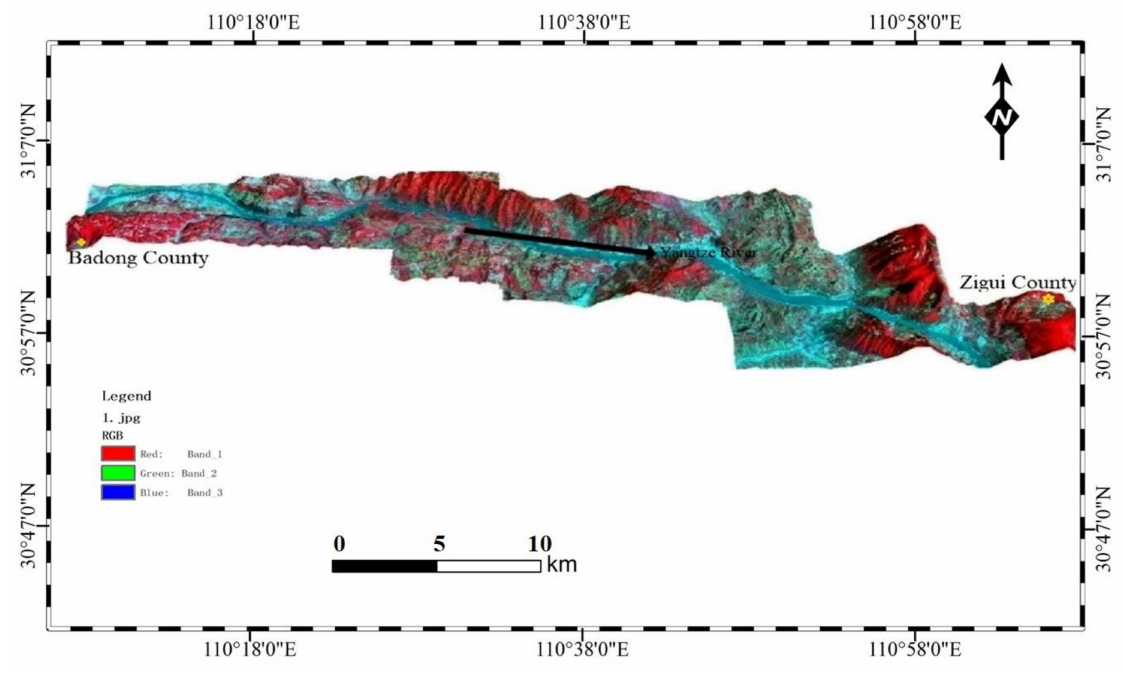
Figure 1. Topographic image of the Zigui–Badong county area (three-dimensional landform overlay Landsat-8